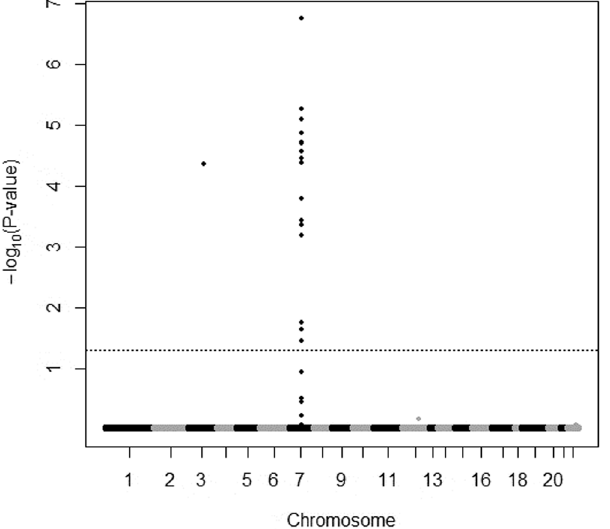
Figure 1. Manhattan plots of variants associated with dose-adjusted tacrolimus trough concentrations on day 7 after transplantation. The dotted horizontal line shows the cutoff of P = 0.05 after false discovery rate correction.